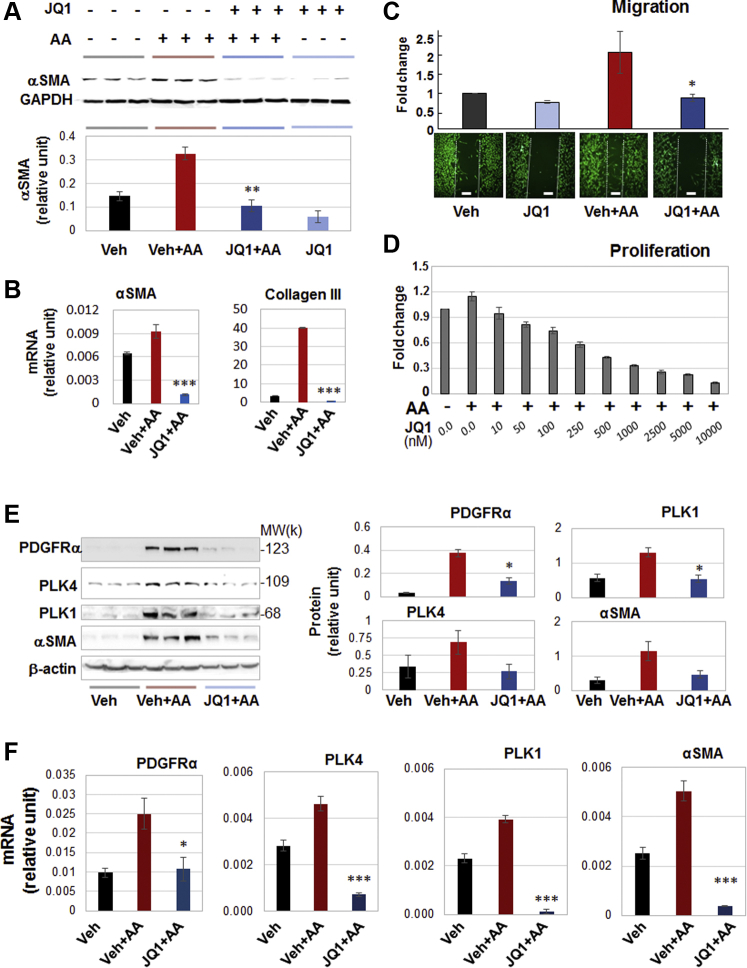
BET Inhibition Blocks AA-Stimulated Fibroblast Cell-Type Transition and Expression of PLK4 and PDGFRαRat adventitial fibroblasts were cultured and starved as described in Figure 1. Cells were pretreated with vehicle control or JQ1 (1 μmol/l or otherwise specified) overnight before AA stimulation and cell harvest for various assays. (A, B) Western blots and qRT-PCR showing JQ1 blockade of AA-stimulated αSMA expression. Densitometry was normalized to GAPDH. (C) Migration (scratch assay). Cells were (or were not) stimulated by AA for 48 h without or with pretreatment (1 μmol/l JQ1). Calcein was used to illuminate the cells. (D) Proliferation. CellTiter-Glo assay was performed after 72 h AA stimulation of cells without or with pretreatment by increasing concentrations of JQ1. (E) Western blots indicating that pretreatment with JQ1 (1 μmol/l, 2 h) abrogated AA-stimulated (24 h) protein production of PDGFRα, PLK4, PLK1, and αSMA. Shown are representative blots from 1 of 2 similar repeat experiments. Densitometry was normalized to β-actin. (F) quantitative real-time polymerase chain reaction data indicating that pretreatment with JQ1 (1 μmol/l, 2h) abrogated AA-stimulated (24 h) mRNA expression of PDGFRα, PLK4, PLK1, and αSMA. Quantification: mean ± SD of triplicates; shown is one of two similar experiments. One-way ANOVA/Bonferroni test: ∗p < 0.05; ∗∗p < 0.01; ∗∗∗p < 0.001 compared with the condition of AA + vehicle. BET = bromo/extraterminal domain–containing protein; JQ1, a BET family–selective epigenetic modulator drug; other abbreviations as in Figures 1, 4, and 11.